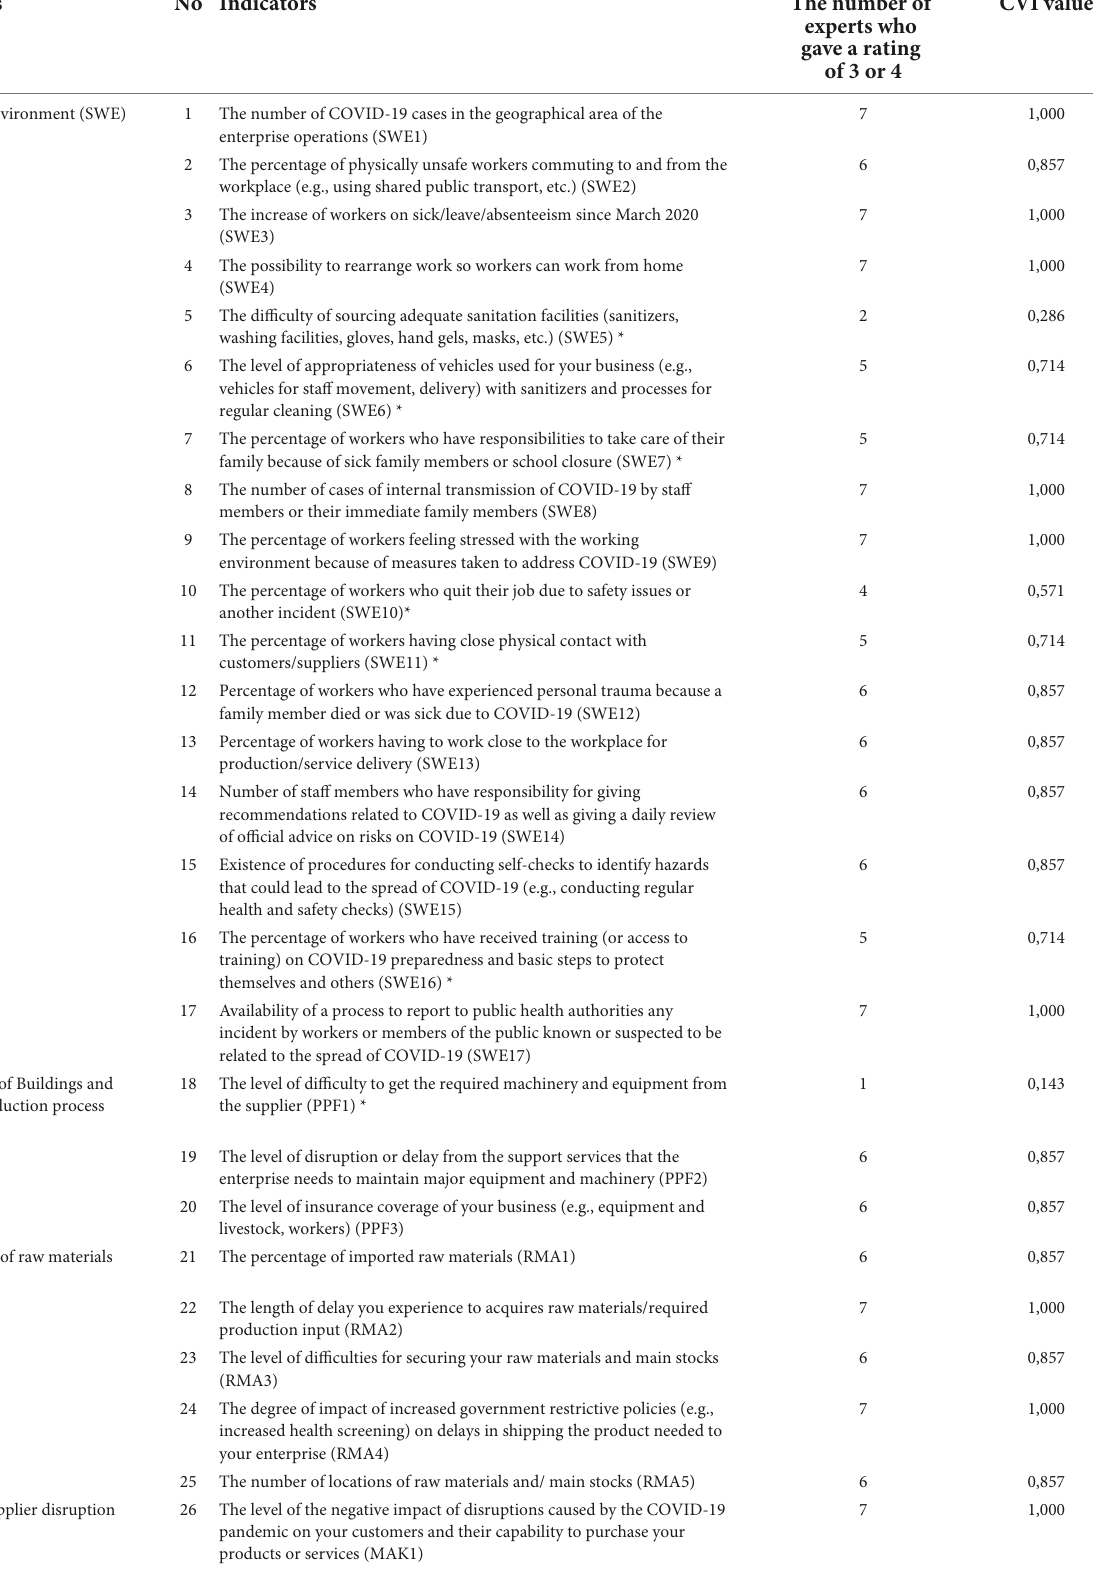
TABLE 2 The results of the content validity of the indicators for measuring the impact of COVID-19 on SME performance. Dimensions No Indicators The number of